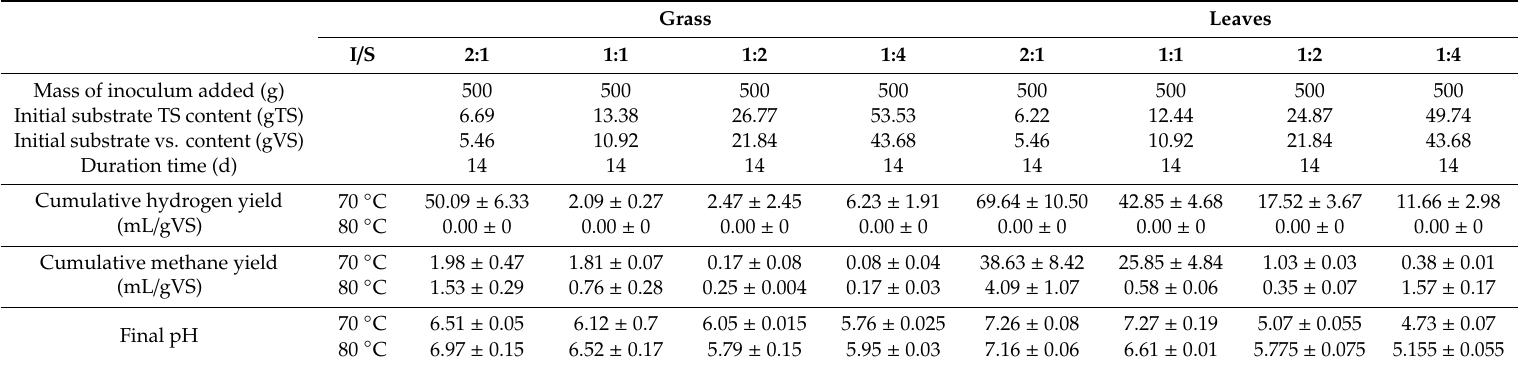
Table 2. Operating parameters and performances of the experiments with biogas